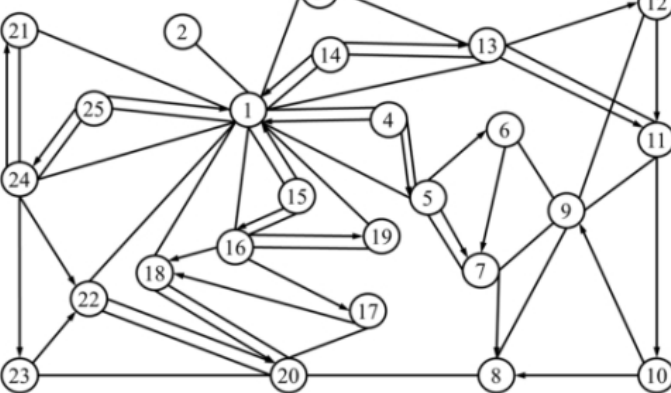
Figure 8. Hybrid diagram of worm reducer disassembly.